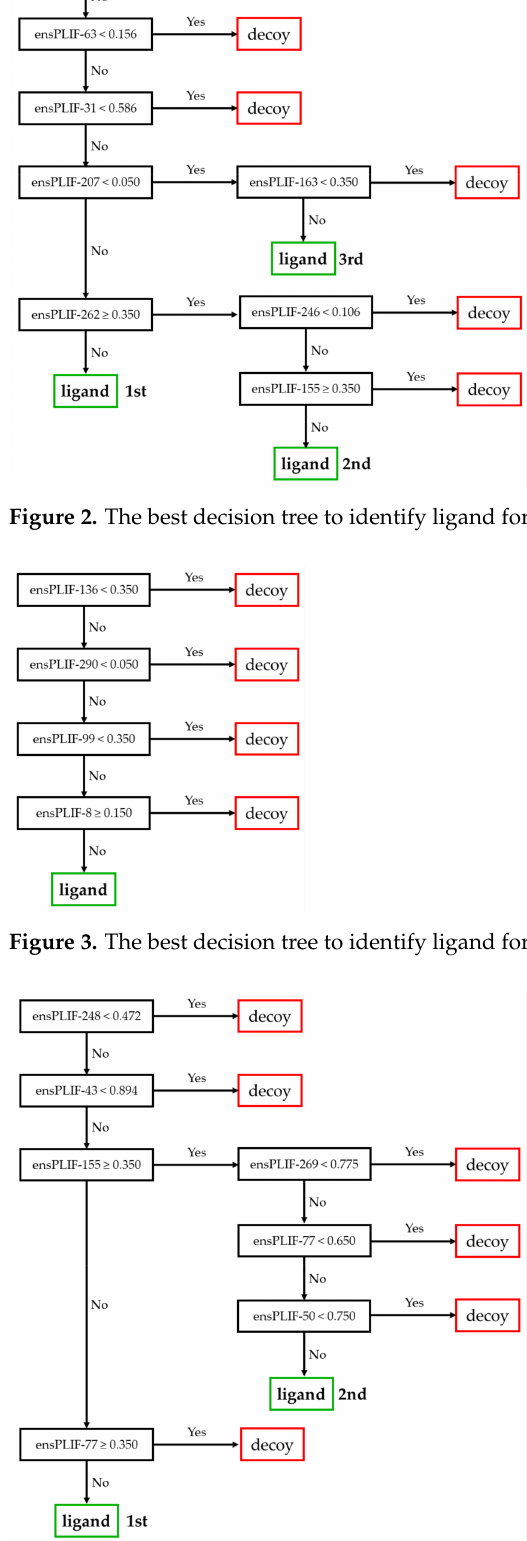
Figure 4. The best decision tree to identify ligand for